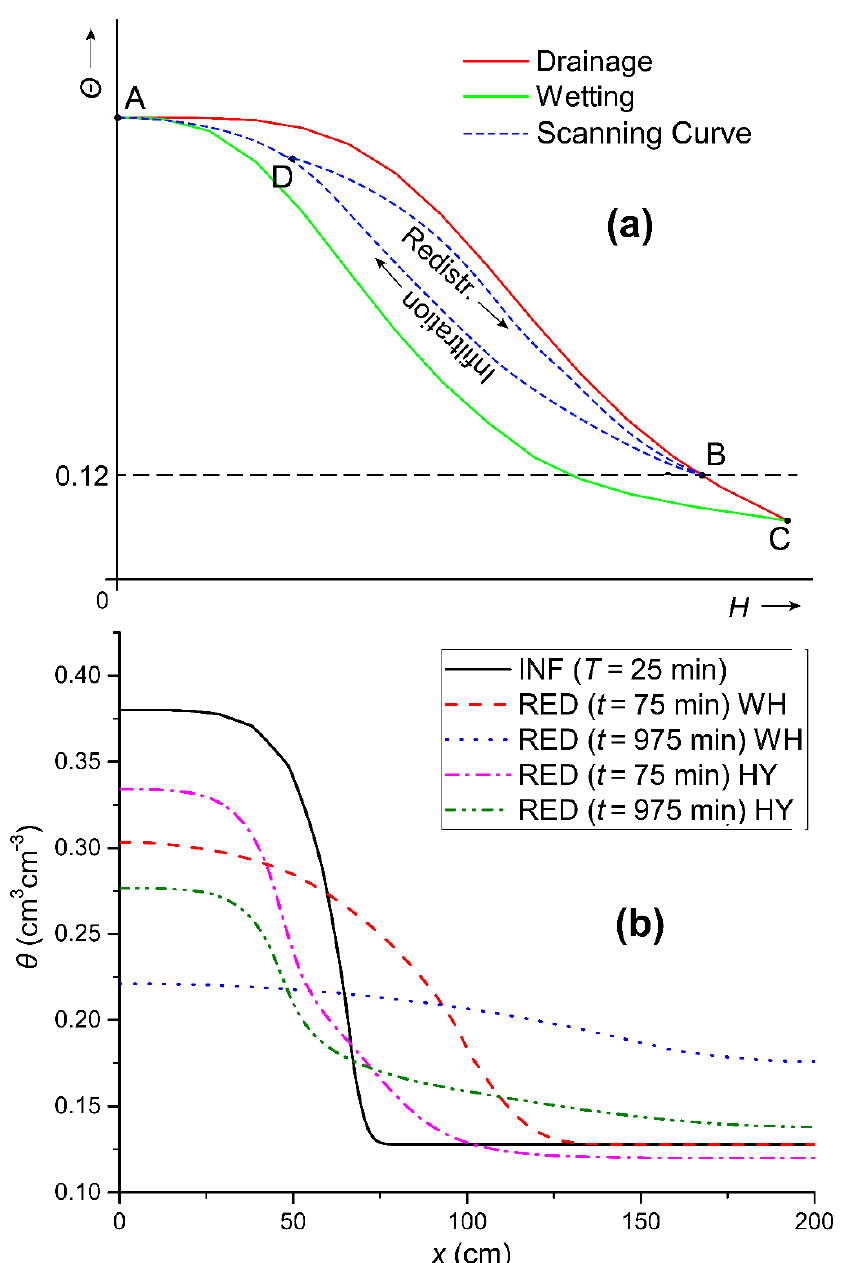
curve soil water redistribution profile development was not advanced up to that distance ( x = 200 cm) for both cases (HY or WH).